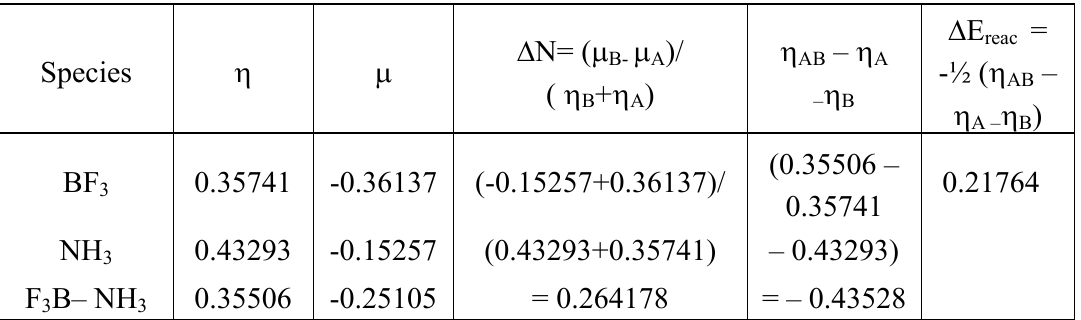
Table 3. Global hardness ( η ), Chemical potential ( µ ) of BF charge transfer ( ∆ N) and reaction energy ( ∆ E) (all in